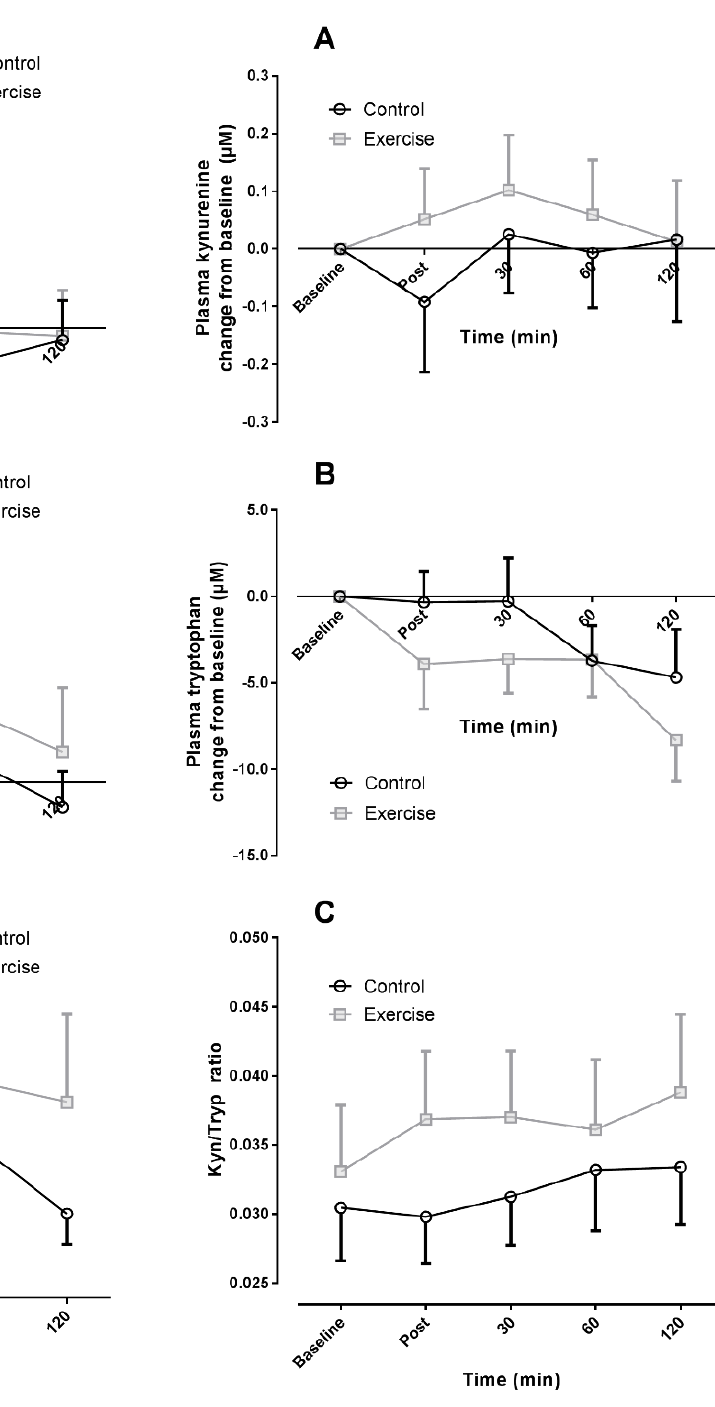
Figure 4. Plasma neopterin (A) and total neopterin (B) were measured using amine-HPLC and subtracted from baseline values.